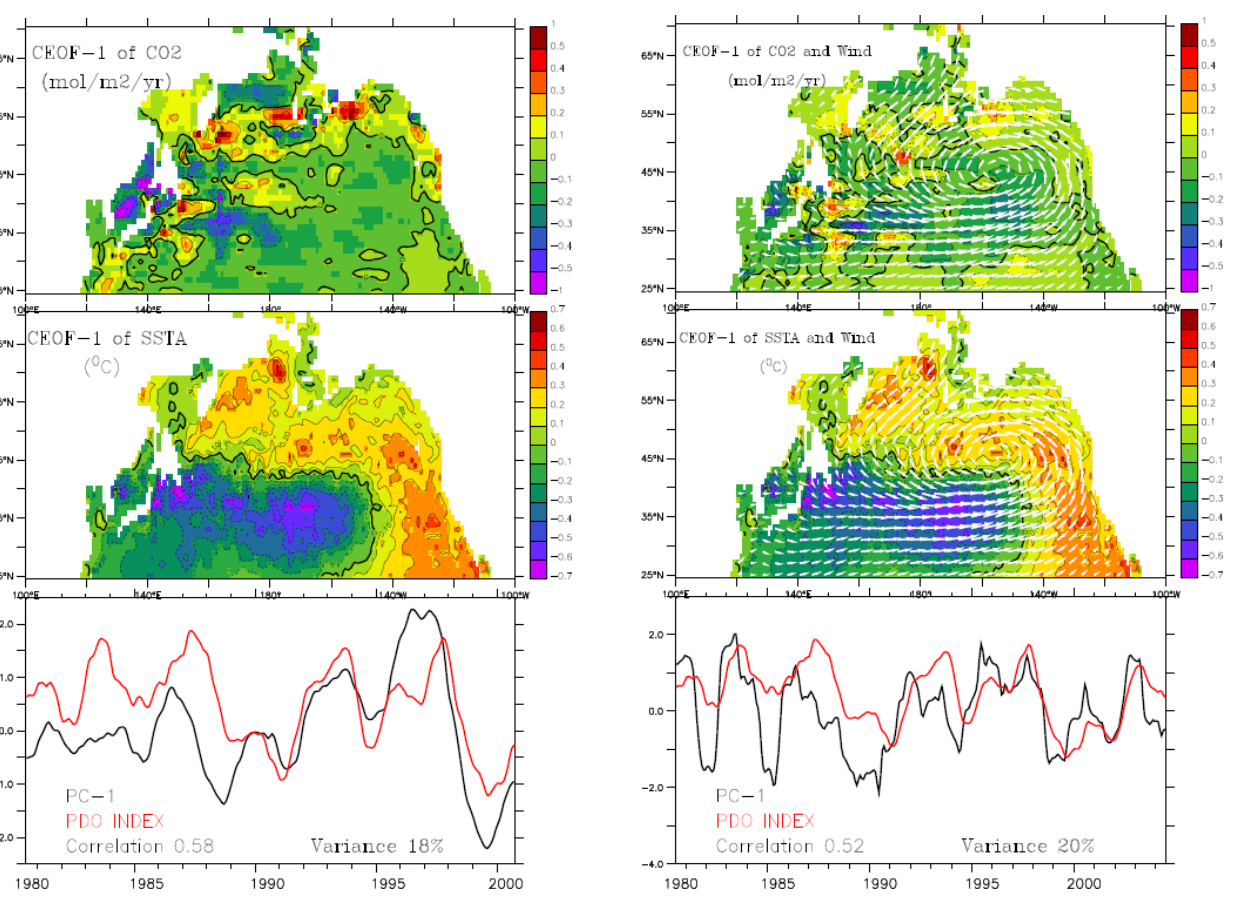
Figure 10: Same as Figure 9, but for CEOFs of CO 2 flux and wind stress anomalies. The middle panel 3 Fig. 10. Same as Fig. 9, but for CEOFs of CO 2 flux and wind stress is same as the middle panel of Figure 9, but CEOF-1 wind stress vectors overlaid. 4 anomalies. The middle panel is same as the middle panel of Fig. 9, but CEOF-1 wind stress vectors